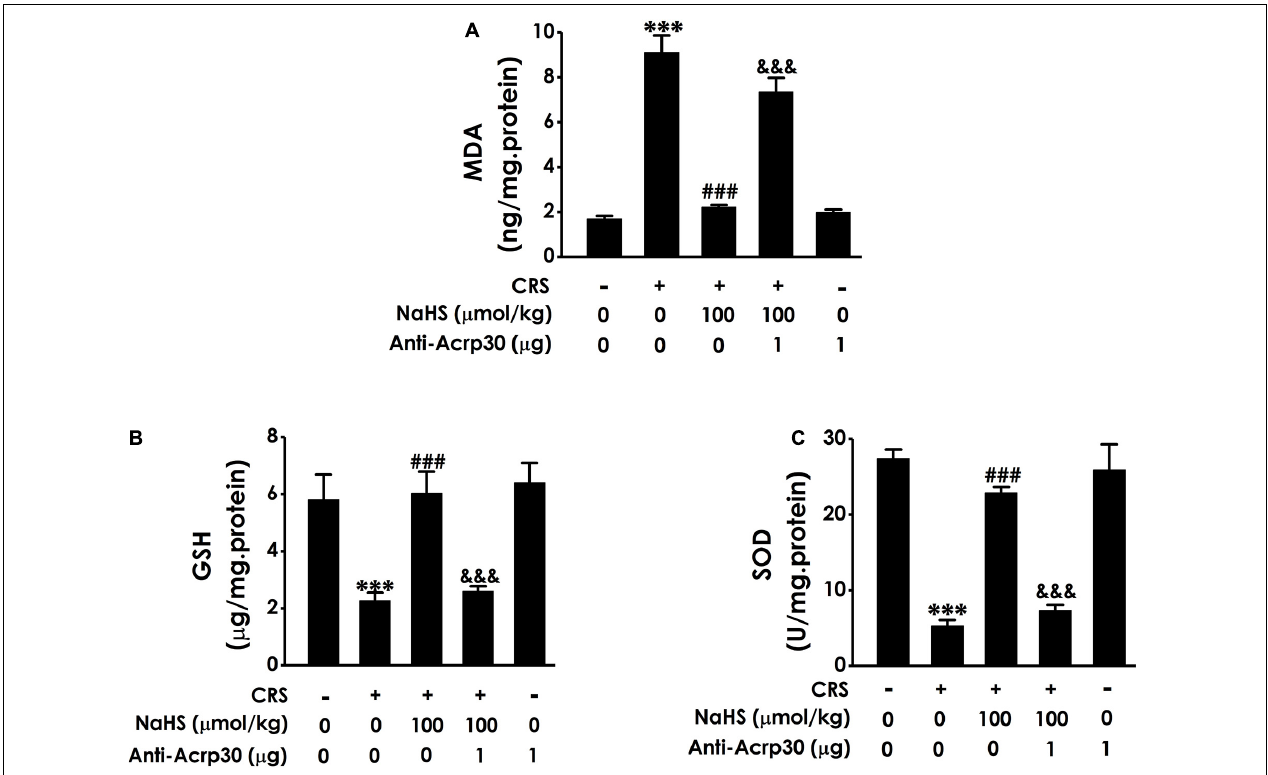
FIGURE 6 | Effects of Anti-Acrp30 on NaHS-mitigated hippocampal oxidative stress in the CRS-treated rats. Rats were co-treated with NaHS (100 µ mol/kg/day, i.p.) and CRS (6 h/day) for 3 weeks, and then co-administrated with Anti-Acrp30 (1 µ g/day, i.c.v.) for further 1 week. (A) The content of hippocampal MDA was measured by malondialdehyde (MDA) enzyme-linked immunosorbent assay (ELISA) kit. (B) The level of hippocampal GSH was detected by glutathione (GSH) enzyme-linked immunosorbent assay (ELISA) kit. (C) The activity of hippocampal SOD was determined by NBT kit. Date are mean ± SEM ( n = 3–4/group). *** P < 0.001, vs. control group; ### P < 0.001, vs. CRS-exposed alone group; &&& P < 0.001, vs. co-treatment with NaHS and CRS